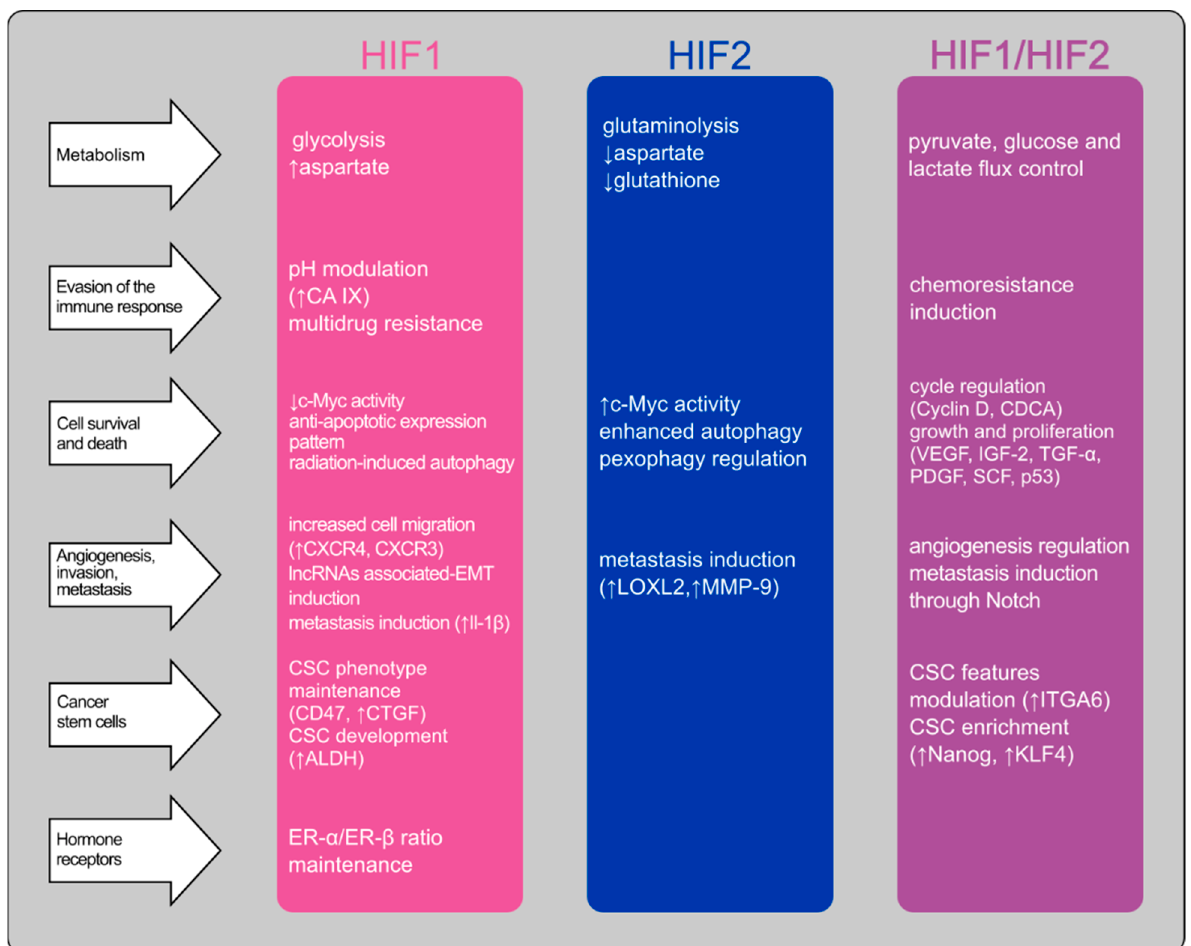
Figure 1. The potential roles of hypoxia-inducible factor isoforms in breast cancer biology. The scheme summarizes the impact of the hypoxia-inducible factors’ activity in breast cancer with a particular focus on the differences between HIFs isoforms. The right column includes the effects of both isoforms’ activity or ones that cannot be assigned to a specific isoform due to a lack of adequate investigation. ↑↓ Increased or decreased expression, activity or amount.